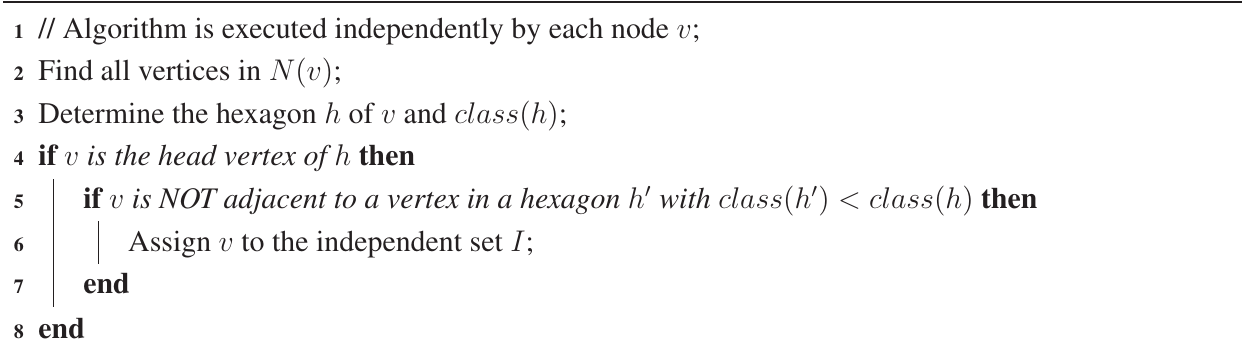
Algorithm 5 : Local algorithm for finding an independent set in a unit disk